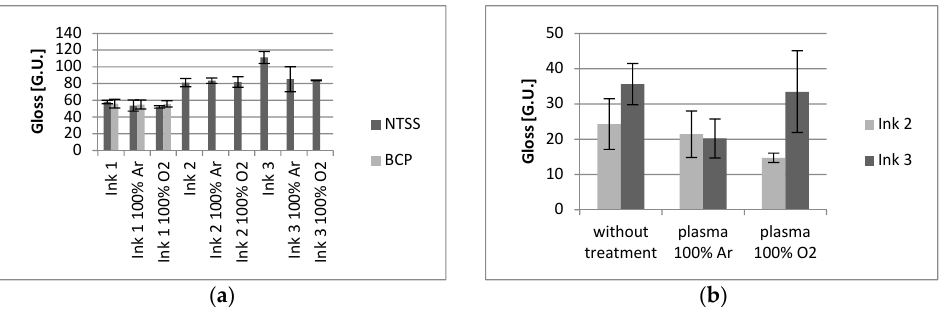
Figure 5. Gloss of prints measured with different geometry: ( a ) 60°; ( b ) 20° for very high gloss prints.